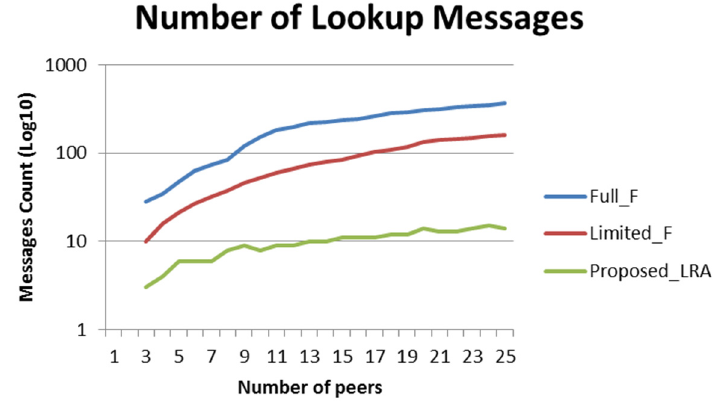
Figure 12. Comparison of the number of lookup messages sent by the different algorithms.